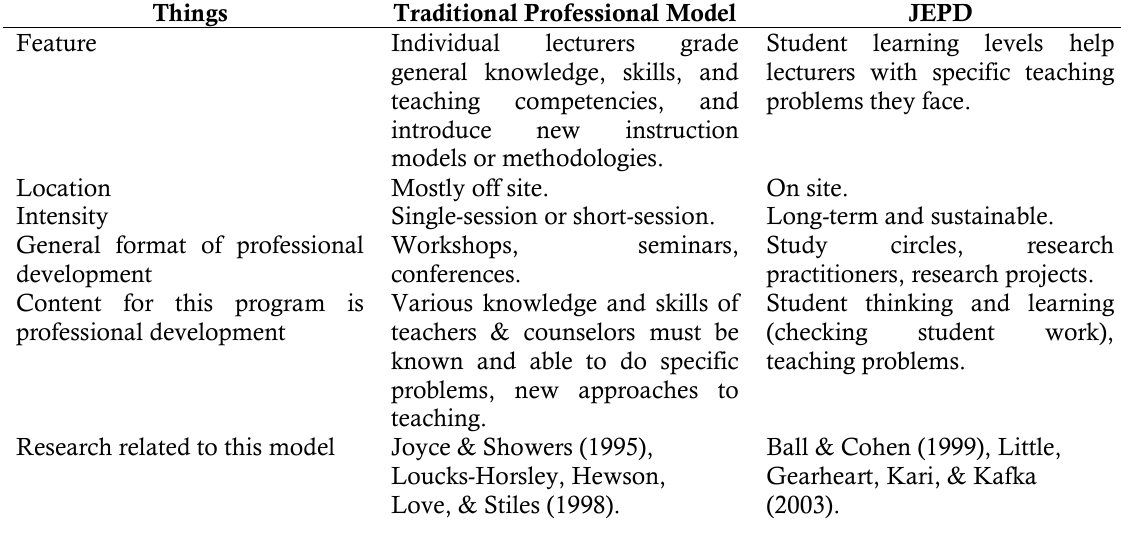
Table 1. Differences between the Traditional Professional Model and the JEPD Model